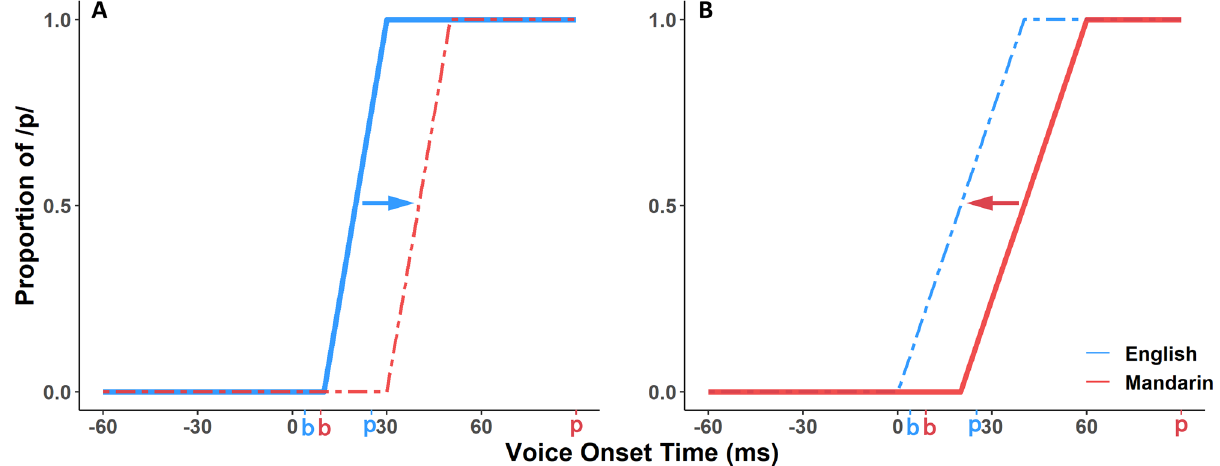
Figure 5. Schematic of the Slope transfer model of phoneme perception for bilinguals. Prototypical productions for voiced and voiceless stop consonants are shown. English = blue; Mandarin = red. ( A ) A hypothetical English- dominant bilingual with English-tuned steep slope transferred to the category boundary position for perception of later acquired Mandarin. ( B ) A hypothetical Mandarin-dominant bilingual with Mandarin-tuned slope transferred to the category boundary position for perception of later acquired